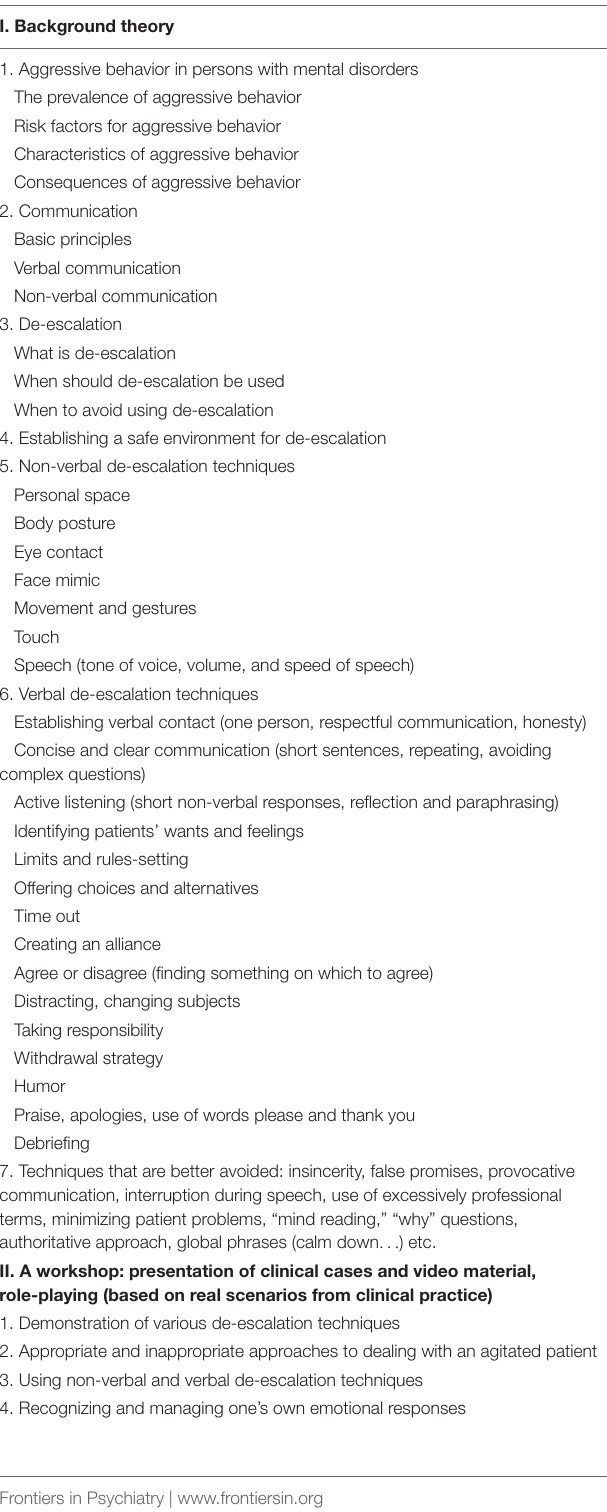
TABLE 1 | De-escalation training